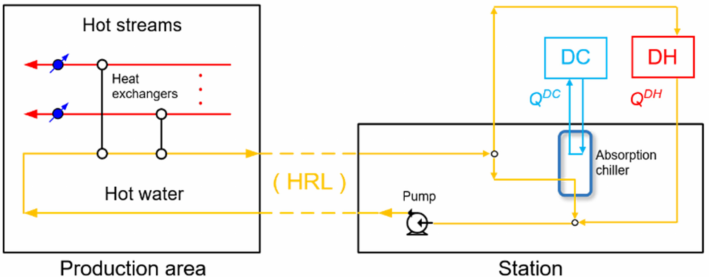
Figure 1. The indirect integration between waste heat and the district heating and cooling (DHC)